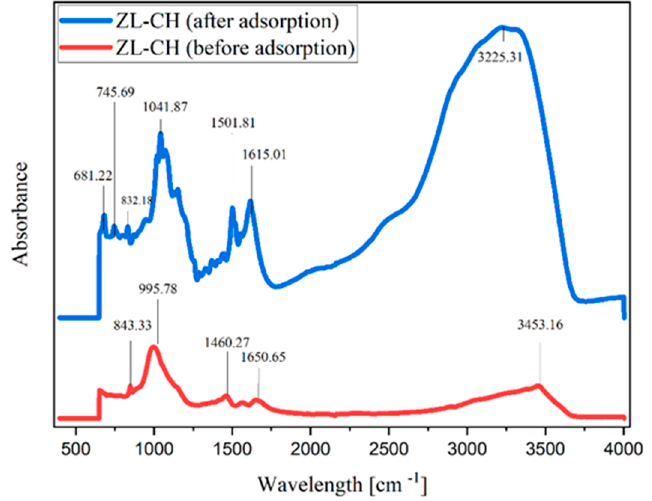
Figure 7. FTIR data of zeolite chitosan (ZL–CH hydrogel) before and after adsorption process.